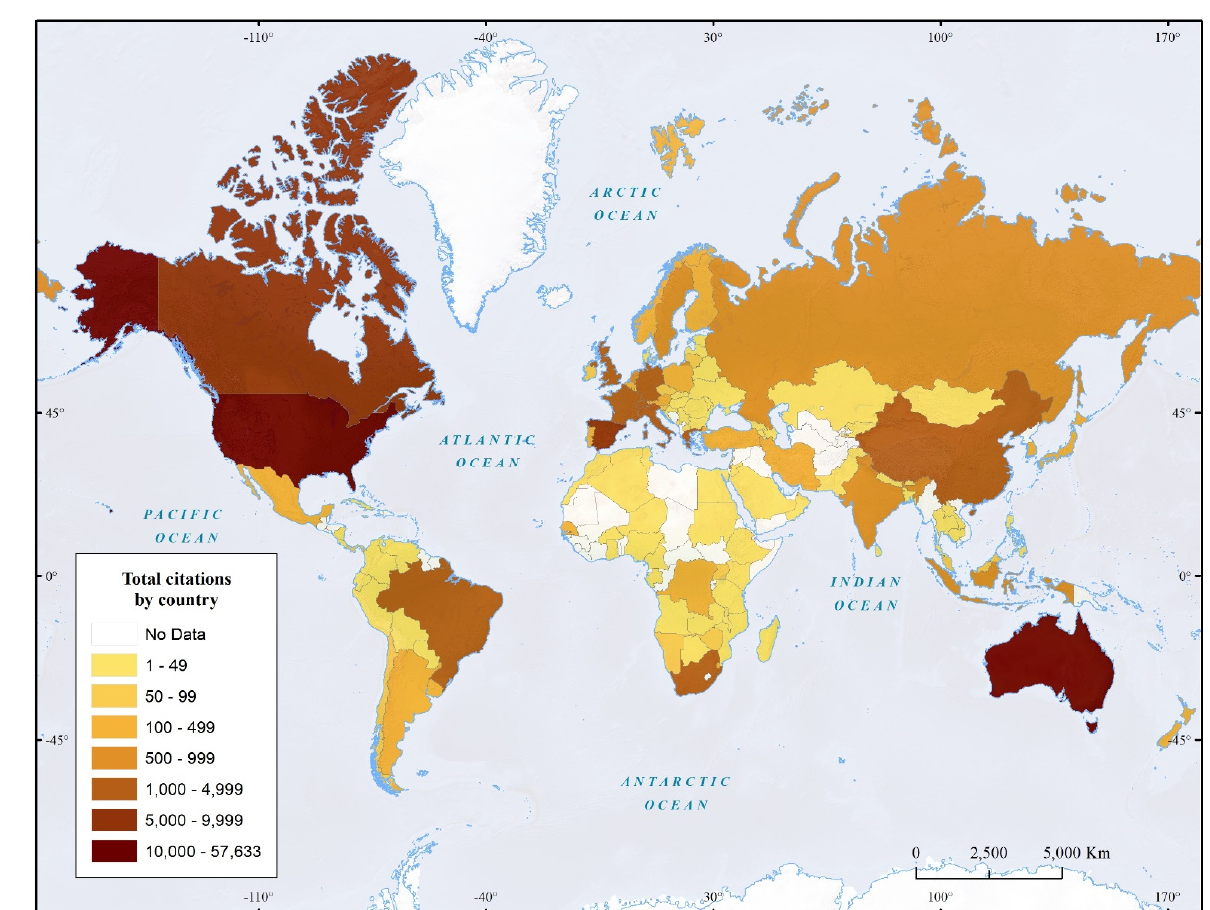
Figure 4. Citations listed in Scopus (1973–2021) per country.